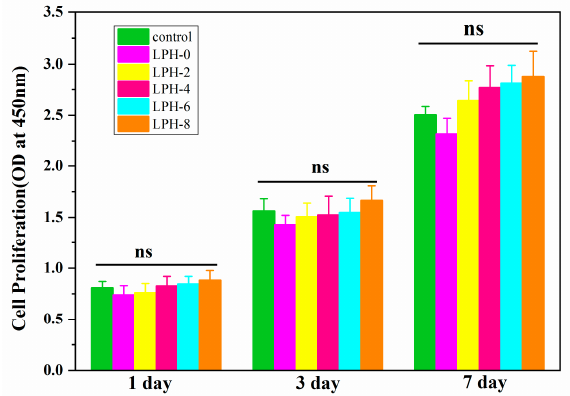
Figure 11. The viability of rBMSCs cultured on the LPH scaffolds after different cell ‐ culture periods.